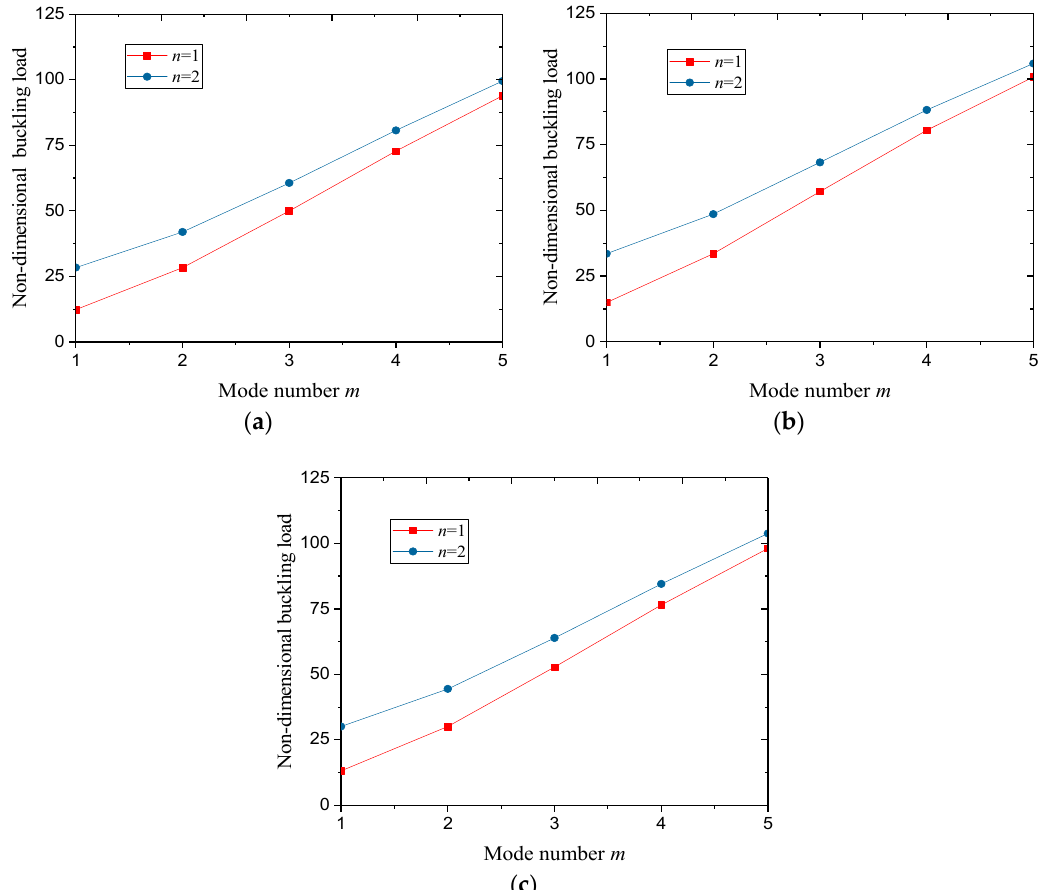
Figure 9. Variation of the non-dimensional buckling load with mode number m ( ζ = 1, h = 5 nm, g = 0.5, l a = l b = 50 nm, λ = 0.5): ( a ) UD, ( b ) NUD1, ( c ) NUD2.